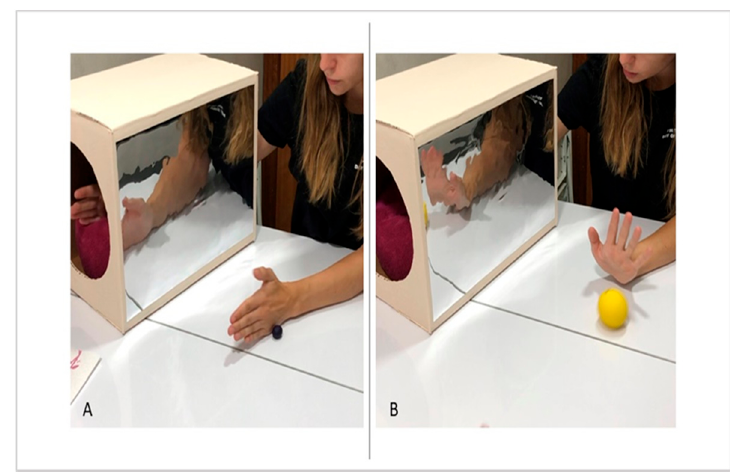
Figure 1. Conventional MT. It is observed the use of mirror in the midline to perform the activities while the child must look in the mirror when the exercise is executed. In the picture ( A ), it is executed the forearm supination to crush the plasticine balls with the back of her left hand (healthy hand), while the right hand is into the box, trying to imitate the same movement. In the picture ( B ), it is seen the wrist extension movement to throw the ball and try to stop it.